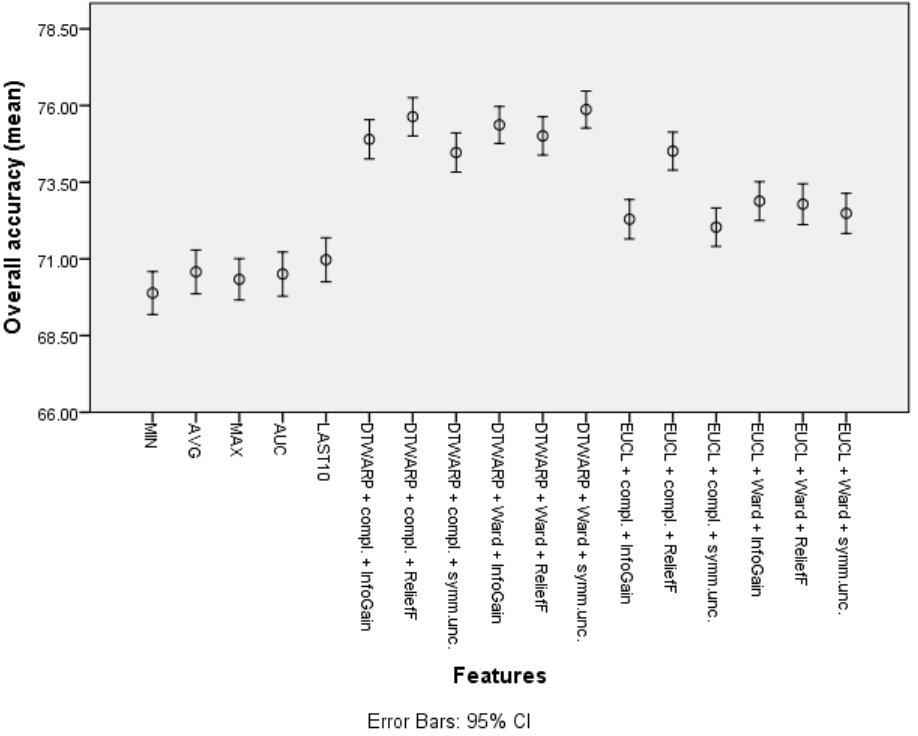
Figure 10. The overall accuracy of Random Forests: mean values and 95% confidence intervals.